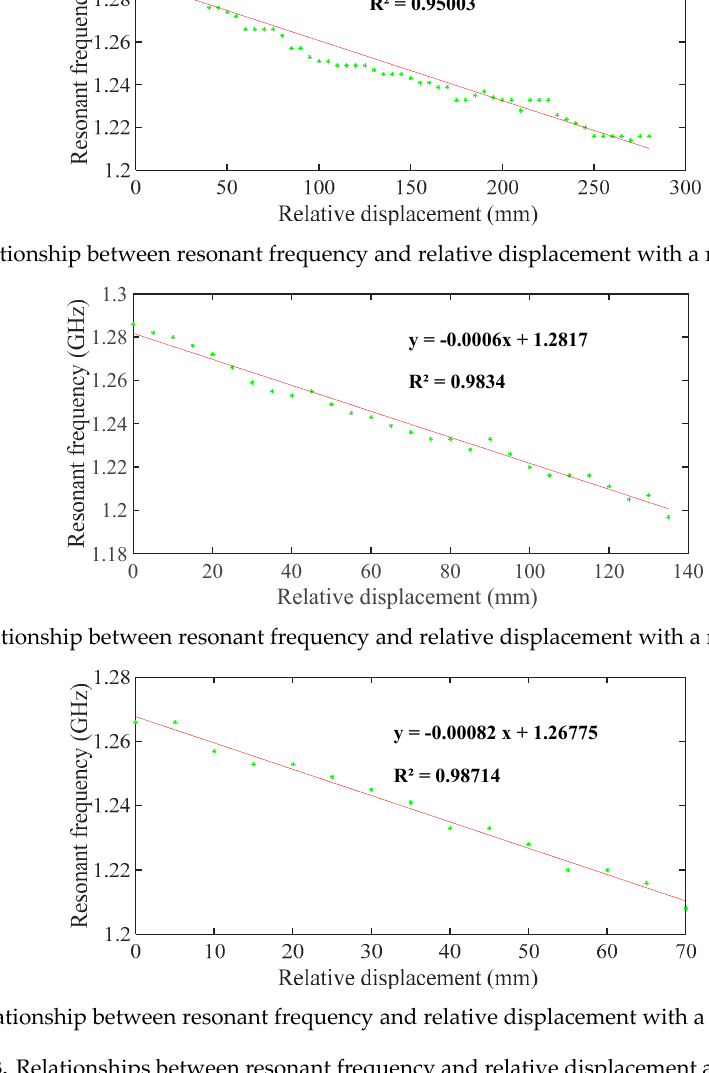
Figure 13. Relationships between resonant frequency and relative displacement at different ranges. Table 2. Sensor experimental results.